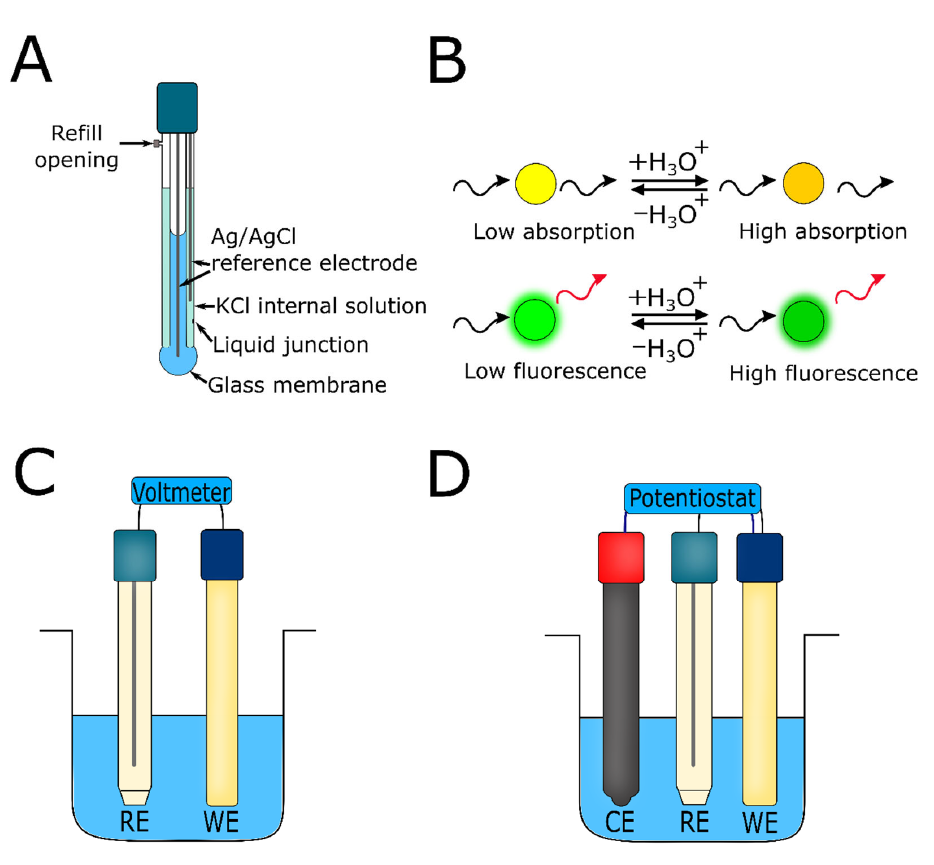
Figure 1. ( A ) Schematic representation of a cell with a glass electrode. Two Ag/AgCl electrodes are immersed in two solutions (with known and unknown pH values, respectively) and separated by a glass membrane. The electrical potential difference between the two electrodes is correlated to the pH of the unknown solution. ( B ) Schematic representation of the principle of optical transduction in an optical pH sensor based on absorption and fluorescence. ( C ) Schematization of a 2 ‐ electrode system inside a solution of a given analyte. ( D ) Schematization of a 3 ‐ electrode system for a voltammetric